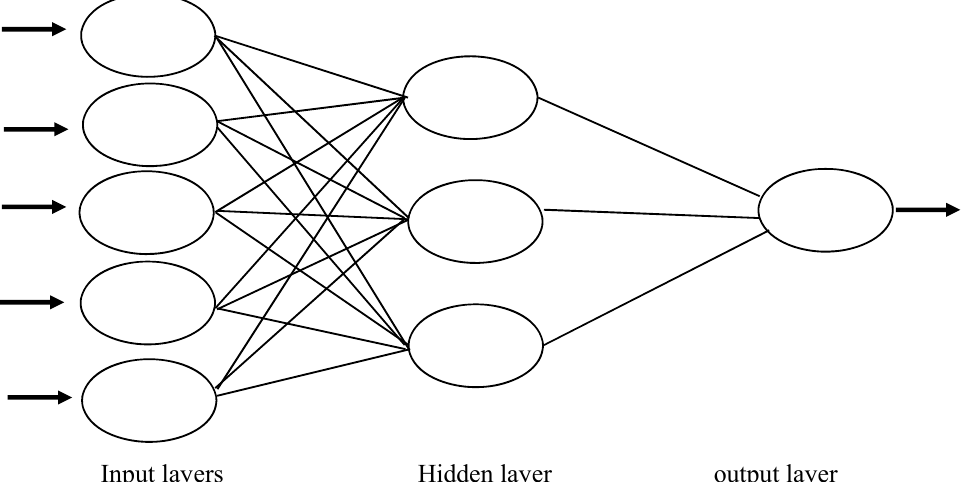
Fig. 1 . An example of a Multiplayer Perceptron (MLP) with one hidden layer for time series forecasting The relationship between the output y